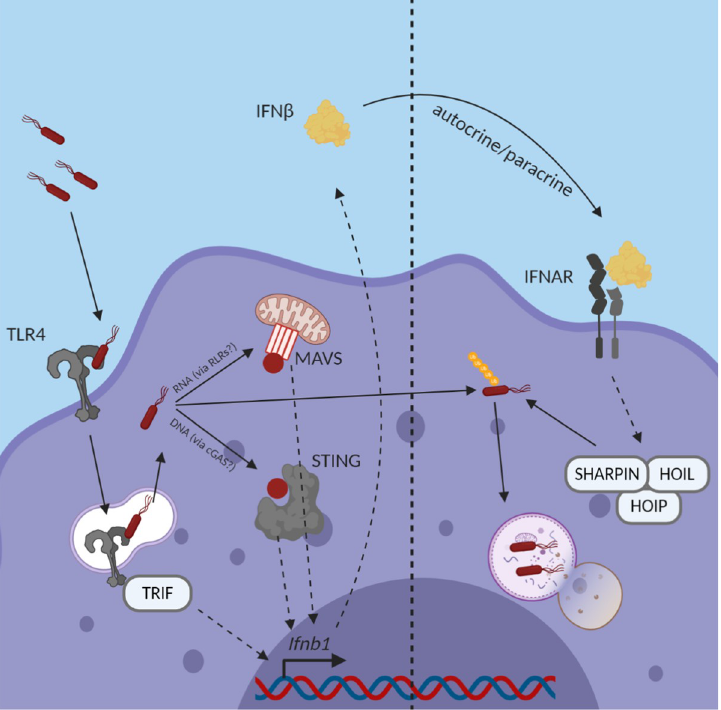
Fig 7. Schematic of Bc- induced IFN production and effects . When Bc enters the lungs, it is recognized by alveolar macrophages and taken up by these phagocytes. TLR4 sensing in the endosome leads to Ifnb1 transcription via the TRIF/TRAM pathway. However, bacterial escape to the cytosol allows for the integration of other signaling pathways like cGAS-STING and the RLR-MAVS pathway, which also contribute to Ifnb1 transcription, and allow for prolonged IFN β production. IFN β acts in an autocrine/paracrine fashion by binding to its receptor, IFNAR, leading to the transcription of various ISGs, including components of the LUBAC complex such as HOIP, HOIL-1, and SHARPIN. The LUBAC proteins then tag the cytosol-dwelling Bc for destruction via the autophagy